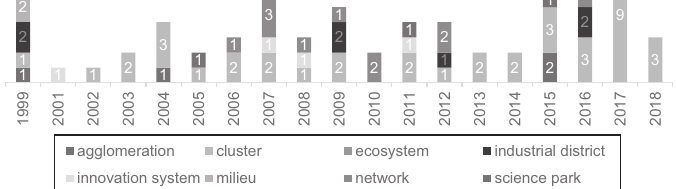
Figure 6. Interorganizational